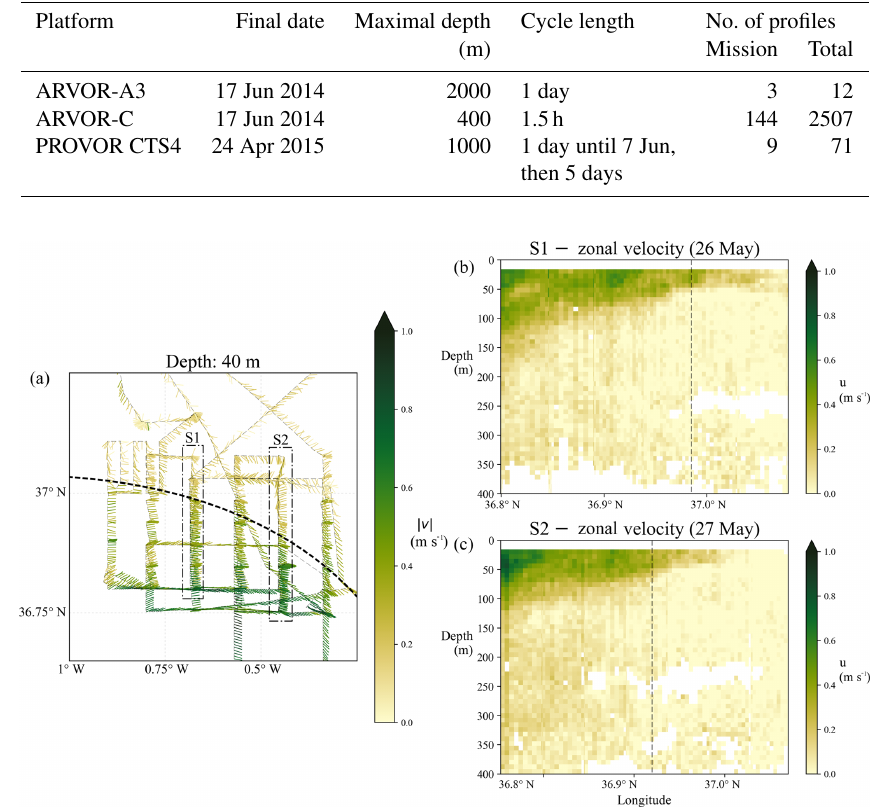
Figure 11. Velocity field obtained with the ADCP at a 40m depth (a) and sections of zonal velocity on 26 May (S1, b ) and 27 May (S2, c ). The locations of the sections are indicated by dashed rectangles on the map. Only data with a quality flag equal to 1 (good data) are